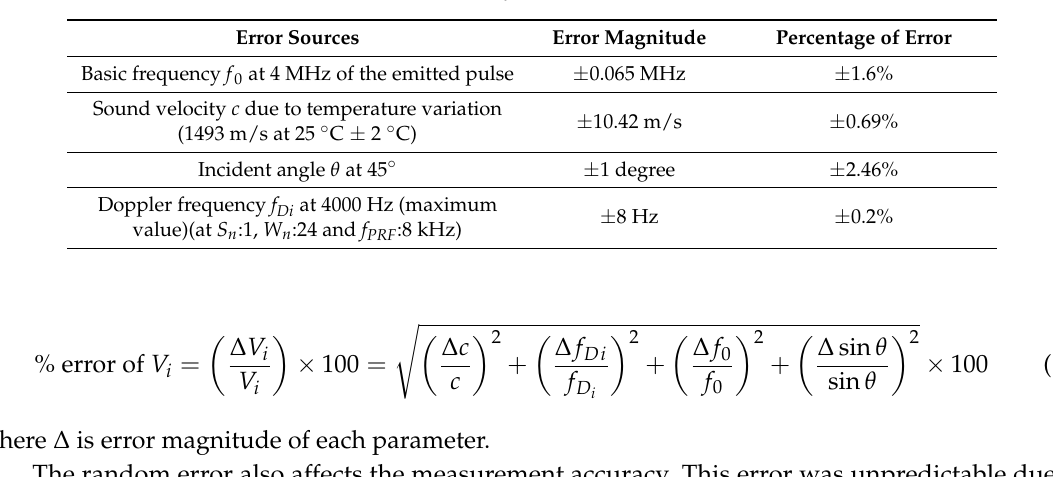
Table 7. Systematic